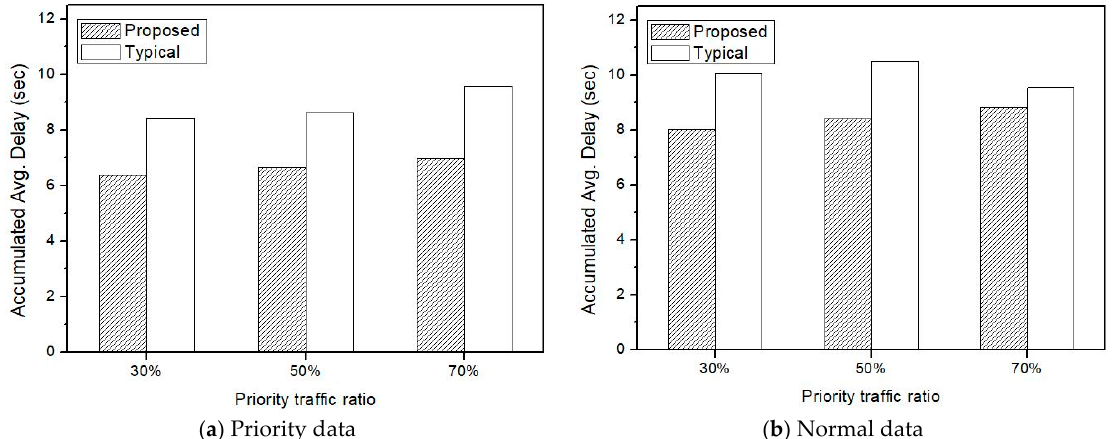
Figure 12. Transmission delay according to IoV high ‐ priority ratio.